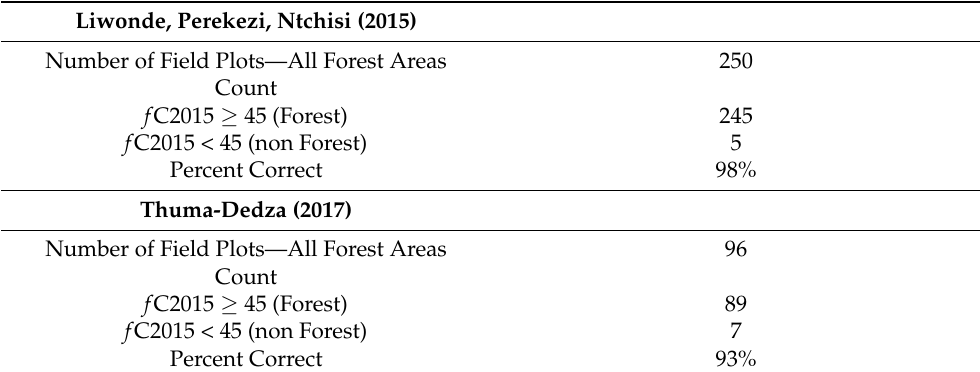
Table A1. The Accuracy of forest cover mapping using the f C method compared to field plots in selected forest reserves.